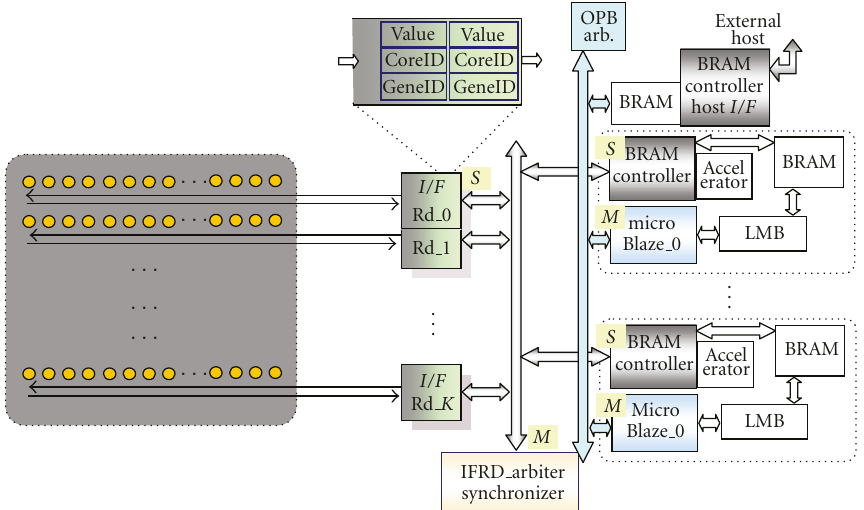
Figure 3: Organization of the multicore microarray data processing SoC; normalization and statistical estimation are performed in parallel in the MicroBlaze cores assisted by harware accelerators.